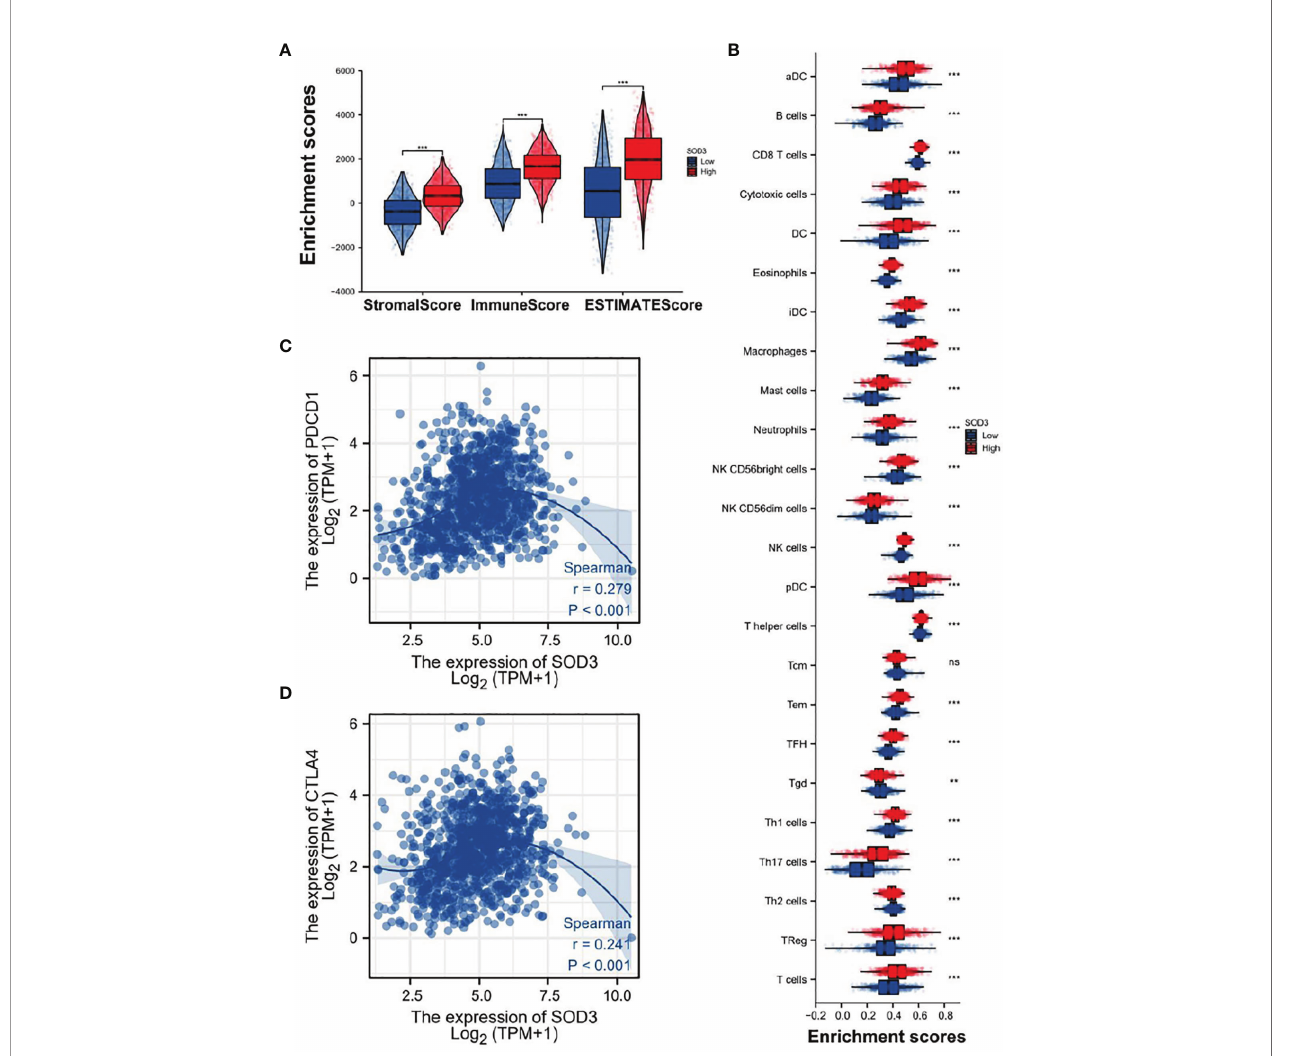
FIGURE 6 | The discrepancy of immune in fi ltration between the high SOD3 expression group and low SOD3 expression group. (A) the stromal score, immune score and ESTIMATE score of lung cancer samples. (B) signi fi cant differences of 24 immune cells in the two groups. (C) correlation between PDCD1 and SOD3 expression. (D) correlation between CTLA4 and SOD3 expression. (***p < 0.001; **p < 0.01). ns, not statistically signi fi